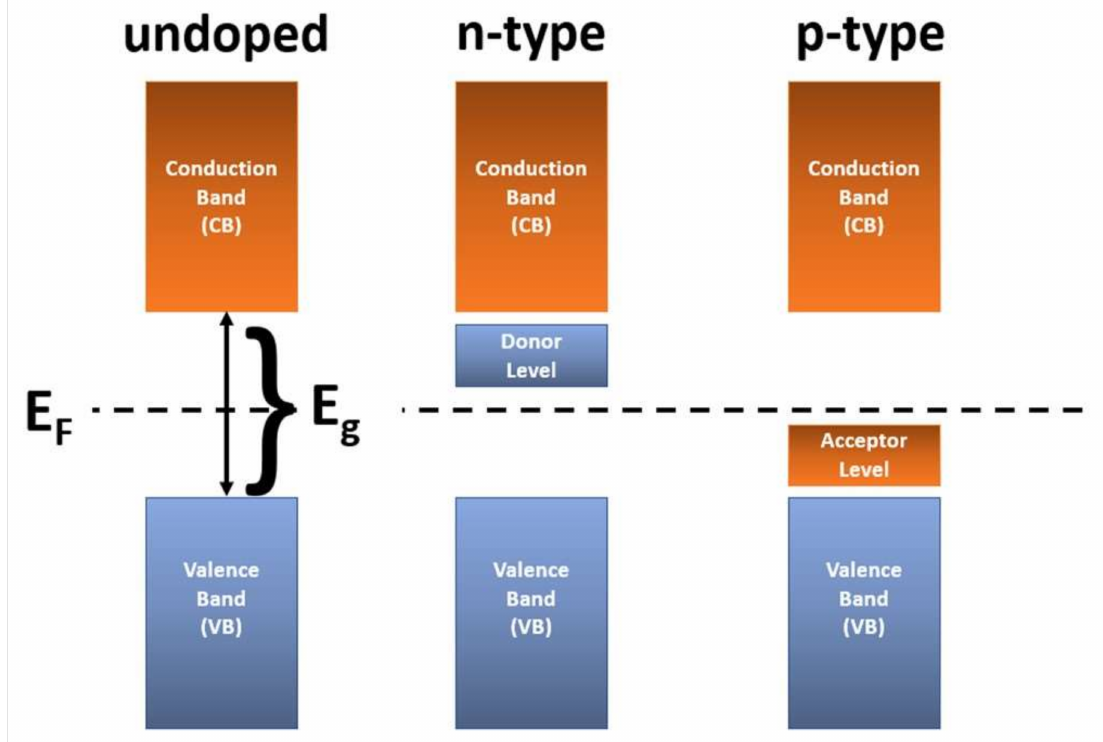
Figure 2. Representation of the Valence Band (VB) and Conduction Band (CB) for the undoped ( left ), n-type ( centre ), and p-type ( right ) doped semiconductors. Notice the relative position between VB, CB, and the Fermi energy level (E F ) in all three